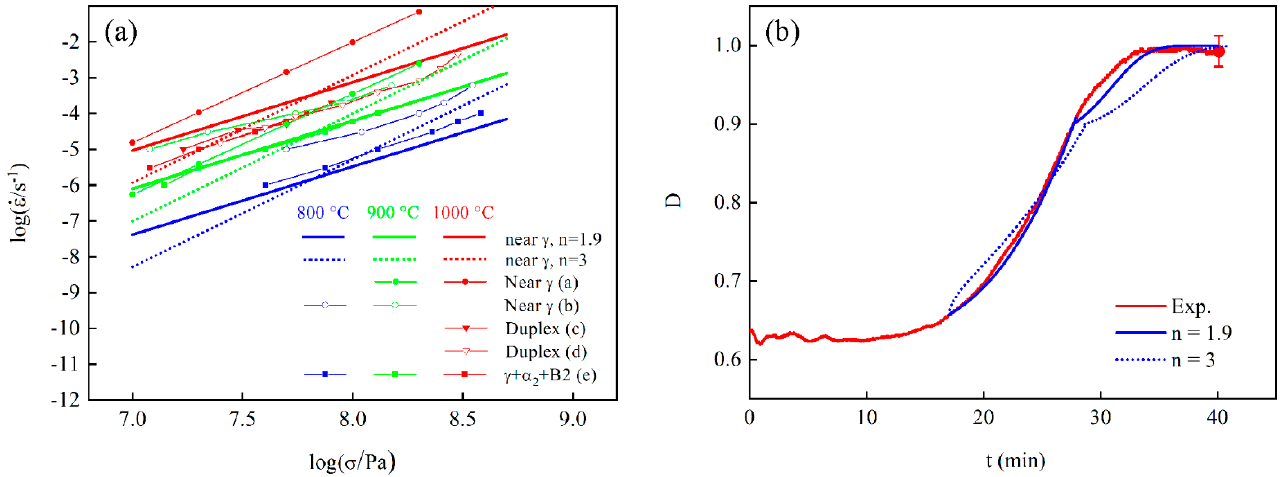
Figure 15. ( a ) Norton laws of a near γ TiAl alloy, taking n = 1.9 and n = 3, the activation energy being identical ( Q = 308 kJ/mol). Comparison with literature data of alloys of similar near- γ and duplex microstructures ((a): [85], (b): [89], (c): [90], (d): [91], (e): [92]). ( b ) Densification curves of TiAl ( D : relative density, t : time) calculated using n = 1.9 [28], and n = 3, compared with experiment.